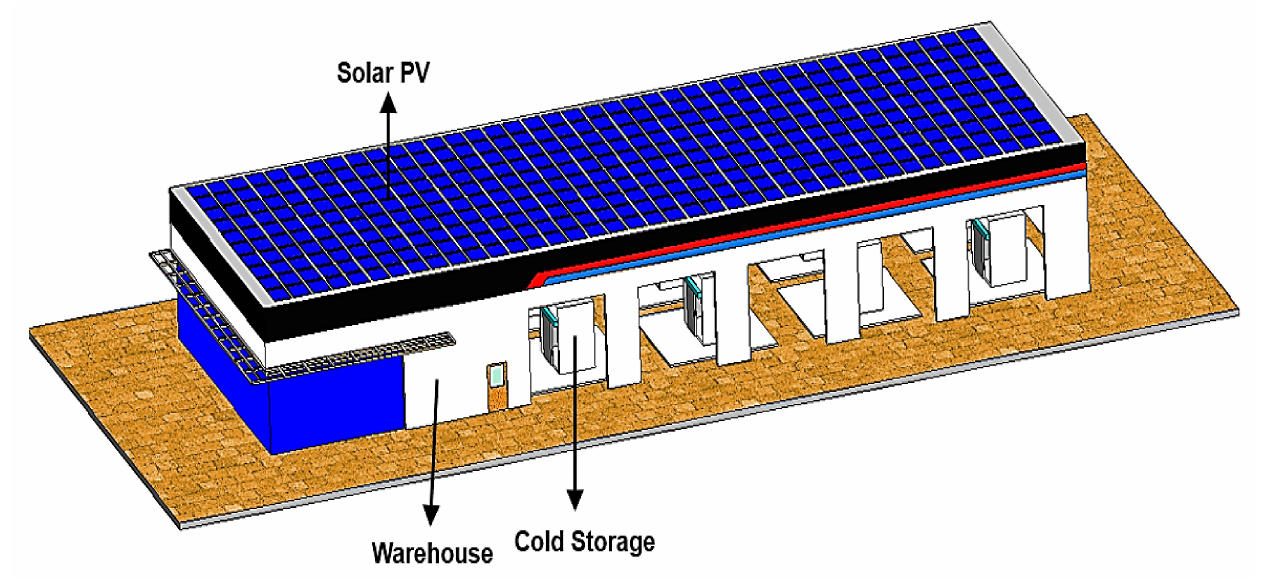
Figure 1. Rooftop Solar Installation on Cold